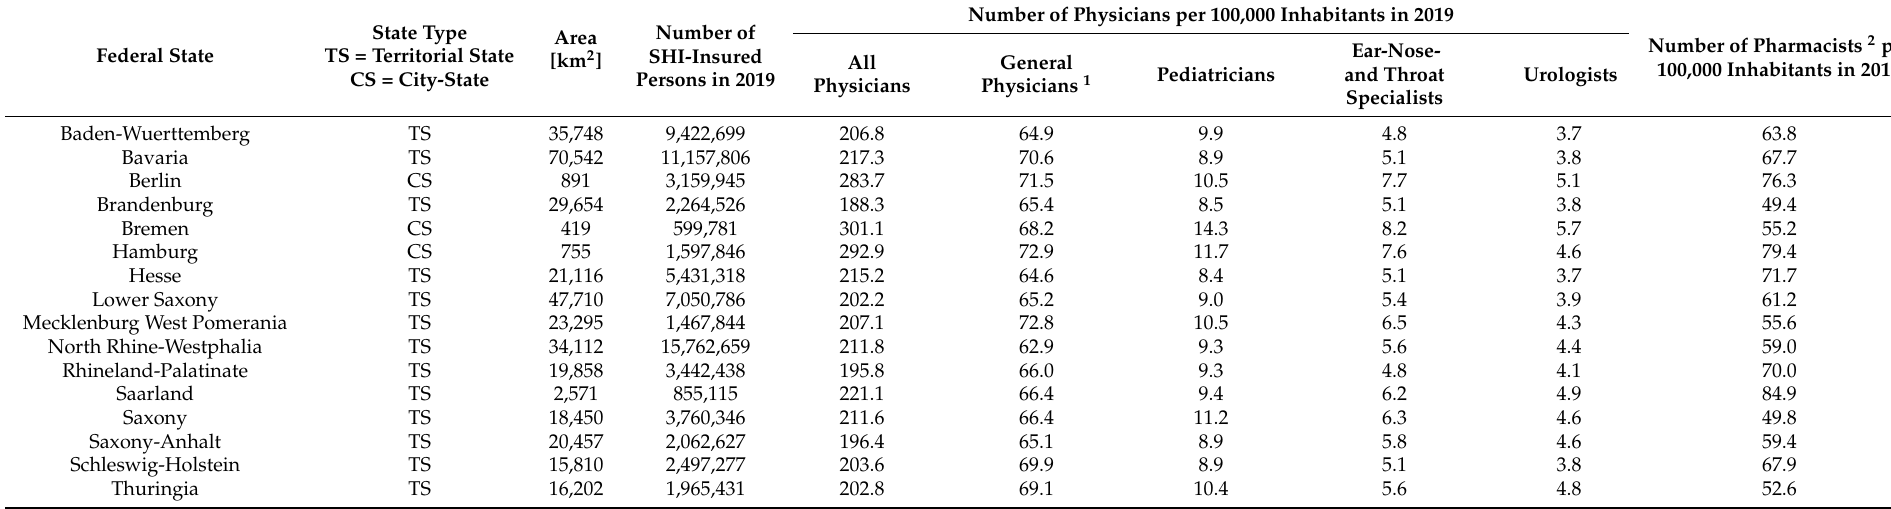
Table 2. Characteristics of German federal states, by state type, area, number of persons insured by statutory health insurance (SHI) funds (Source: [23]), physician density (Source: [24]) and density of community pharmacists in